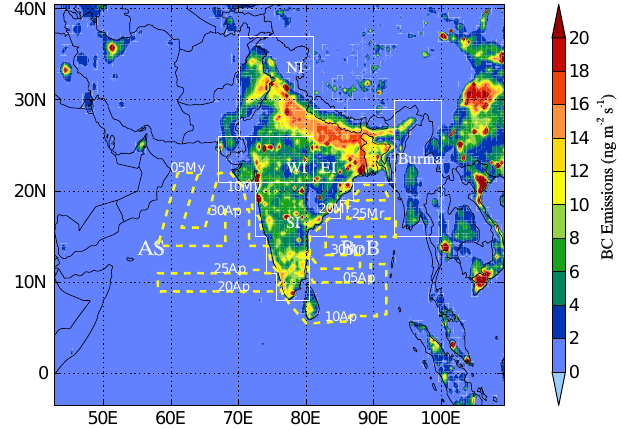
Figure 1. Spatial distribution of anthropogenic BC emissions over the model domain. Different regions from which BC emissions are tagged are shown with the Bay of Bengal and the Arabian Sea. Yel- low line represents the ICARB ship track, with the number standing for day of Month: Mr (March), Ap (April) and My (May). NI, WI, EI and SI represent north, west, east and south India,